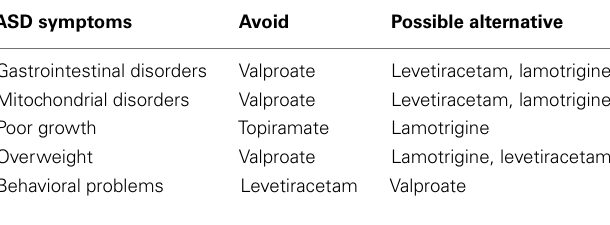
Table 4 | Guidelines for selecting a first-line antiepileptic drug for children with autism spectrum